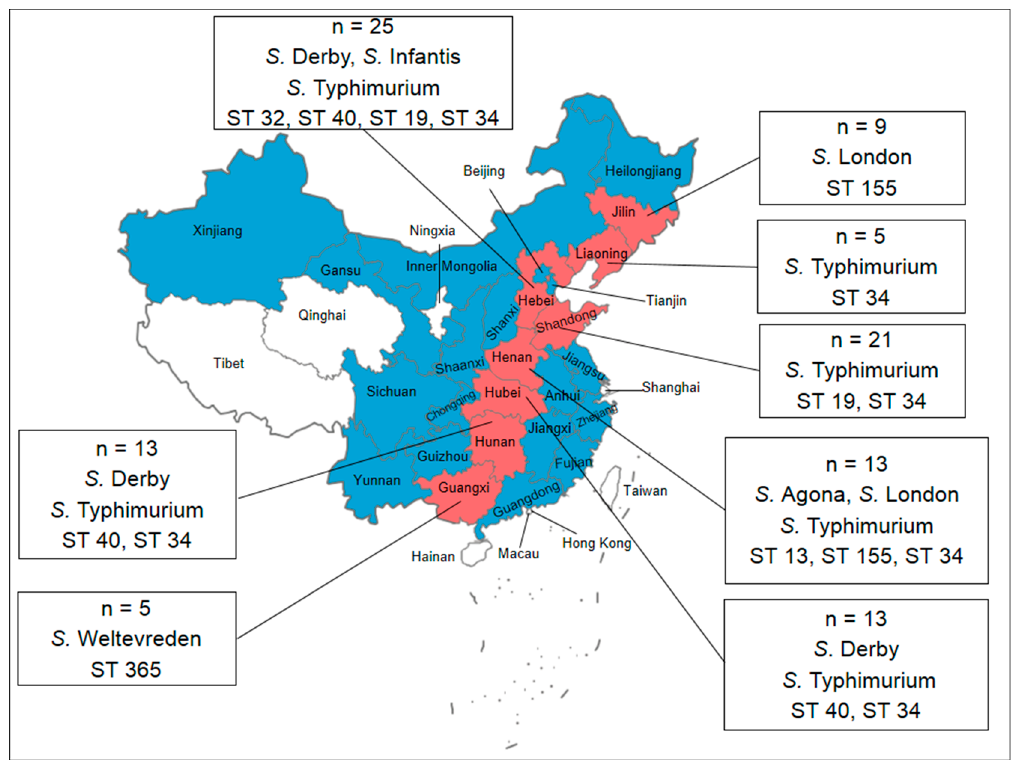
Figure 1. Map of China showing the samples from pigs with diarrhea from 26 provinces in China. Red in the map indicates Salmonella -positive sources, and the numbers indicate the numbers of Salmonella isolates. The data in the box indicate the distribution of the serovars and STs isolated from the pigs with diarrhea.